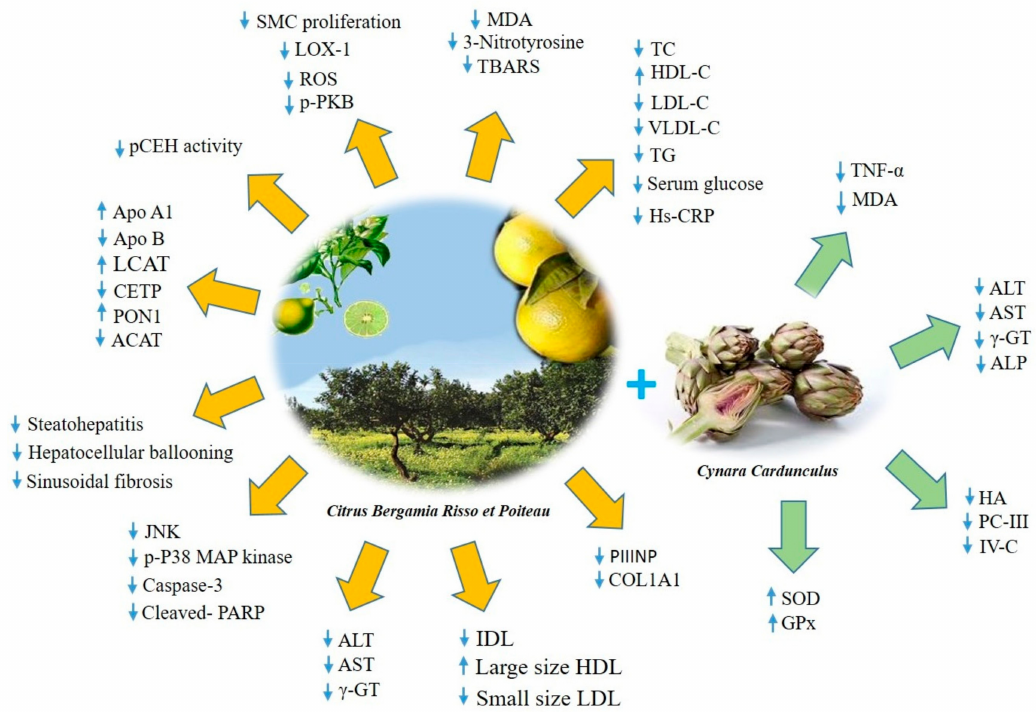
Figure 2. The molecular mechanisms involved in the beneficial e ff ects of bergamot polyphenols.